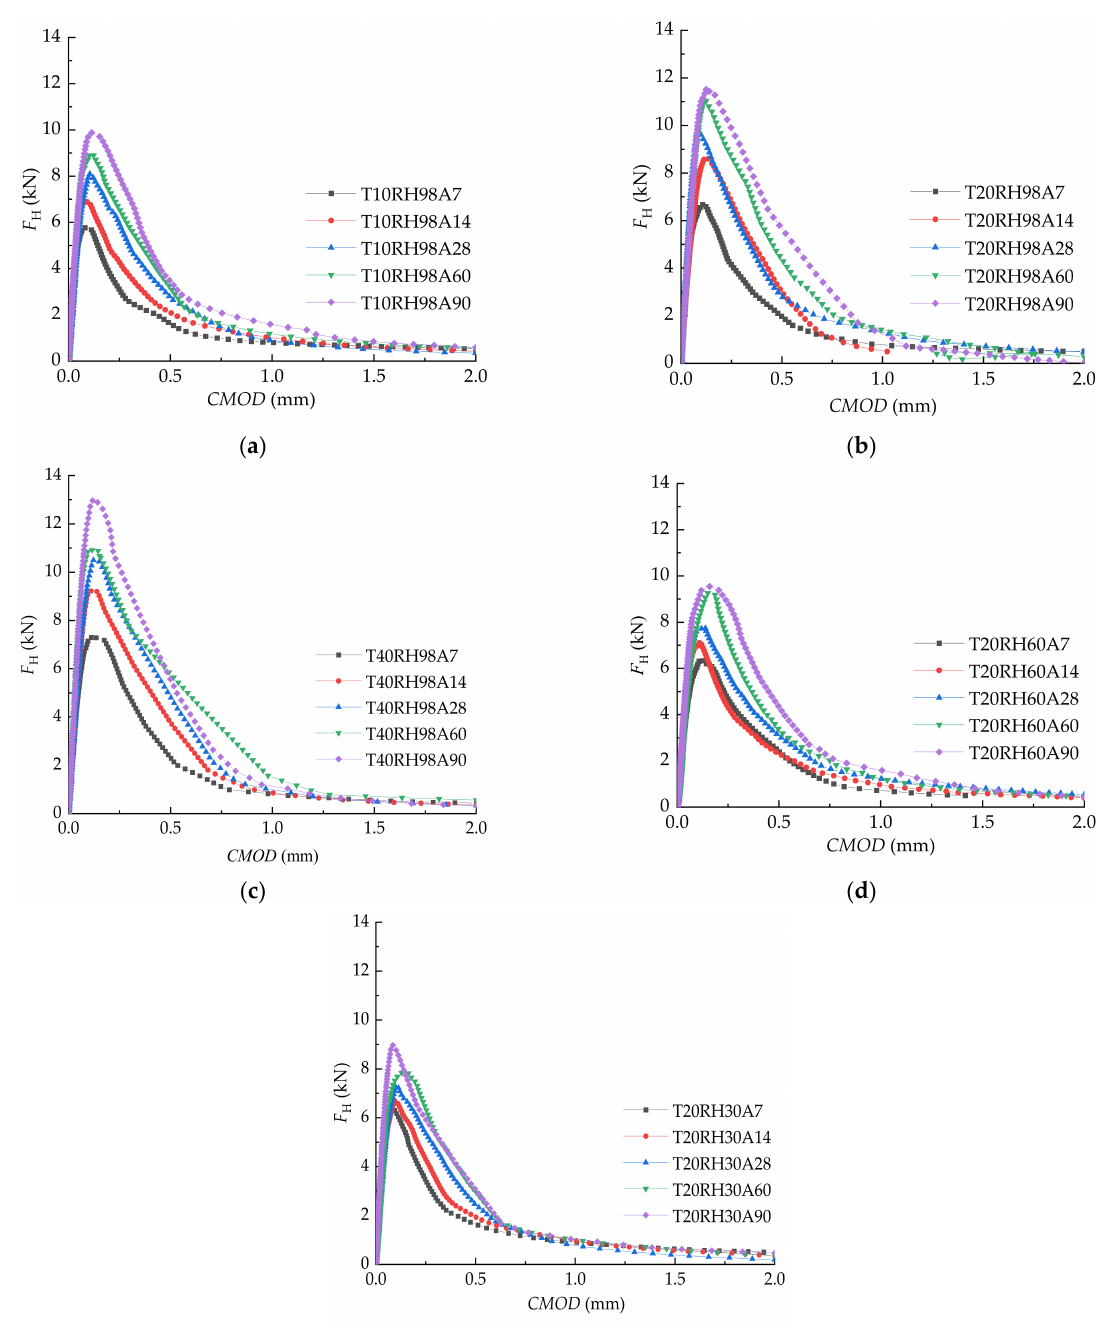
Figure 10. Load–crack mouth opening displacement curves of wedge-splitting specimens under different curing conditions: ( a ) T = 10 ◦ C, RH = 98%; ( b ) T = 20 ◦ C, RH = 98%; ( c ) T = 40 ◦ C, RH = 98%; ( d ) T = 20 ◦ C, RH = 60%; ( e ) T = 20 ◦ C, RH =